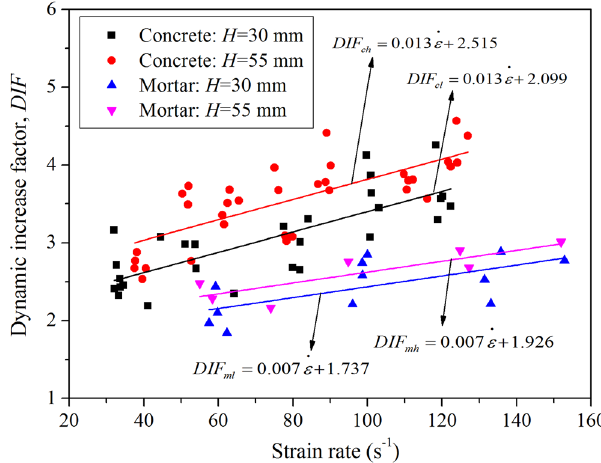
Figure 15. Relationships between the DIF and strain rate for concrete and mortar BD